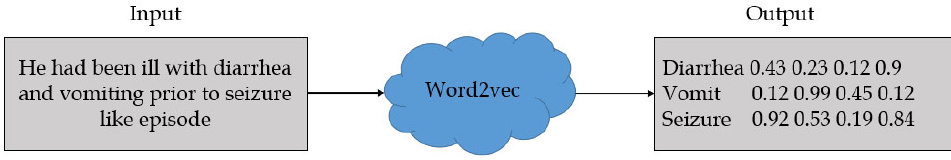
Figure 1. Word2vector process. Figure 1. word2vector process.